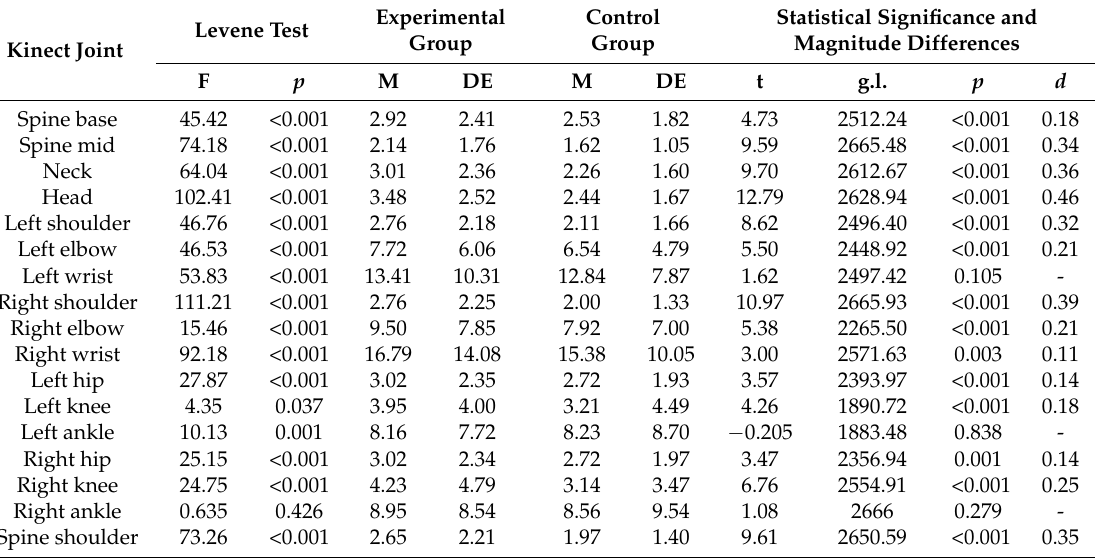
Figure 7. Average differences in movement for every joint in the experimental group and the control group. ** = p < 0.001 ; * = p < 0.05.